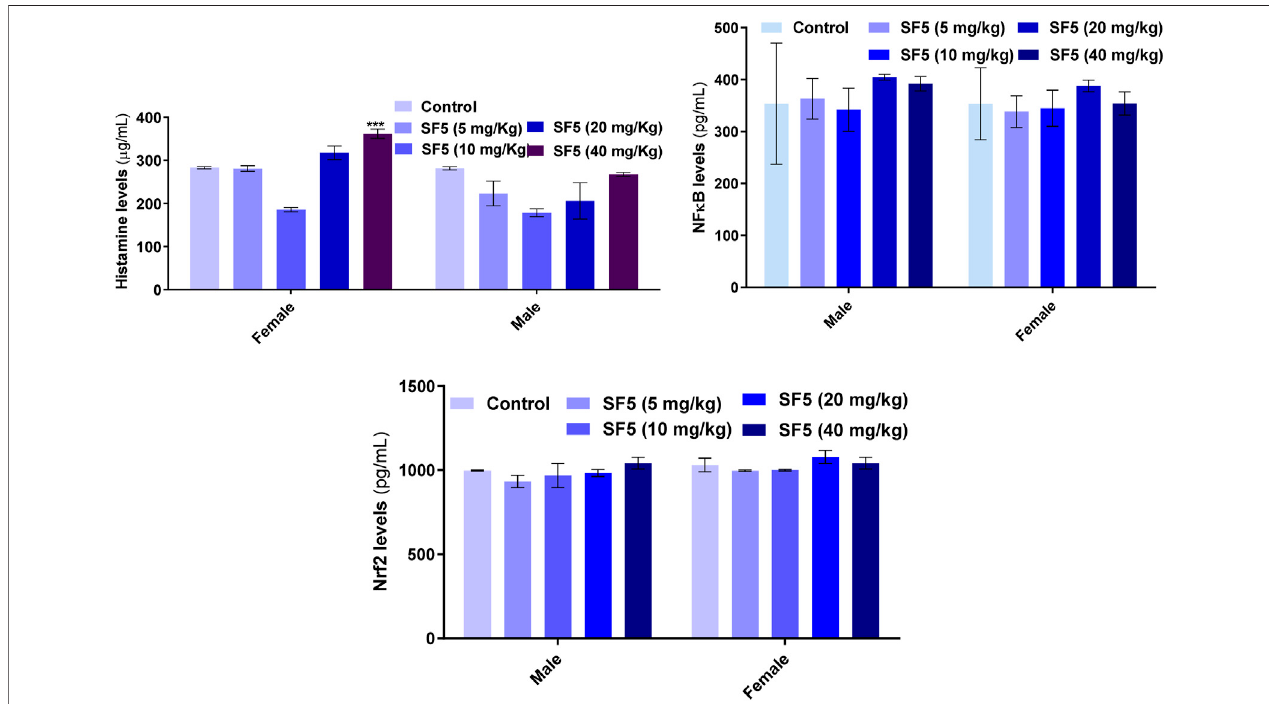
FIGURE 6 | Effect of repeated-dose administration of a different dose of SF5 on histamine, NF- κ B, and Nrf2 levels in the serum of the treated animals in subacute toxicity studies. Data are presented as mean ± SEM, n (cid:1) 3, *** p < 0.01 compared to the control.